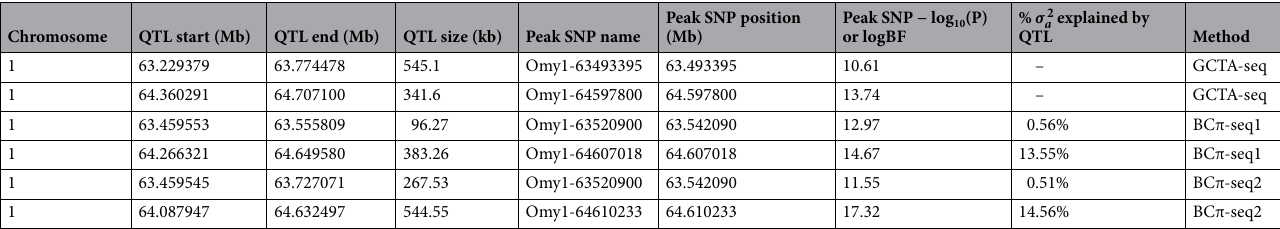
GCTA-seq and BCπ-seq approaches at the whole genome sequence level. Using the WGS data and GCTA-seq approach, significant QTLs were detected only on Omy1, in a restricted region (in-between 62 and 66 Mb). In total six peak SNPs corresponding to six putative QTLs (see Supplementary Table S1 and Supplementary Figure S2) were detected in this region. Therefore, the BCπ-seq approach was performed considering only the 21 K SNP spanning this 4 Mb-window on Omy1 in addition to a genome-wide polygenic component. Using this approach, we identified only two QTLs (Table 5 and Supplementary Figure S3). Out of the six putative QTLs detected by the GCTA-seq analysis, the first one was not confirmed with the BCπ-seq analyses. Therefore, it will not be further discussed, as it is likely that the association is only due to linkage disequilibrium with the SNPs included in the second QTL region. The second putative QTL detected between 63.229 and 63.774 Mb with the GCTA-seq analysis was also detected with the BCπ-seq analyses in a reduced credibility interval (between 63.459 and 63.556 Mb, Table 5); it was hereafter considered as the first true QTL on Omy1. The four remaining putative QTLs from the GCTA-seq analysis were very close to each other, with less than 250 kb between two successive peak SNPs, and the limits of their confidence intervals (CIs) approximated by a drop-off approach were all distant from less than 3 kb. Therefore these four CIs were fused into a single cred- ibility interval of 342 kb. This second QTL was also detected with the BCπ-seq analyses (Table 5). While the peak SNP of the first QTL was the same under the two BCπ-seq analyses, this was not the case for this second QTL. However, the two peak SNPs were separated by 3.2 kb only and their credibility intervals were strongly overlapping (Table 5). Based on the average of the two BCπ-seq analyses, the first QTL explained about 0.5% and the second QTL about 14% of the total genetic variance. At the end of the second QTL, we identified a haplotype block of 15 consecutive SNPs (spanning 745 kb from 64.632011 to 64.632756 Mb) that have a significant effect on masculinisation (all the 15 SNPs have − log 10 (P-value) between 12.2 and 13.6 and among them five SNPs with logBF > 9). Interestingly, for this 15 SNPs-haplotype, eight of the 11 dams with almost no masculinised offspring carried two copies of the reference genome haplotype (the three remaining dams being heterozygous at the15 SNPs). Among the 11 dams with a high rate of masculinised offspring, only three were homozygous for the reference haplotype, six were heterozygous and the last two (labelled AA and AJ in Fig. 1) were homozygous for the alternative haplotype. In the offspring, the homozygous genotype for the alternative haplotype was overrepresented in masculinised fish (51.5% of masculinised fish) and underrepresented in females (8.7% of females). Conversely, the reference haplotype was observed either at the heterozygous or homozygous state for respectively 50.6% and 40.2% of the female progeny.